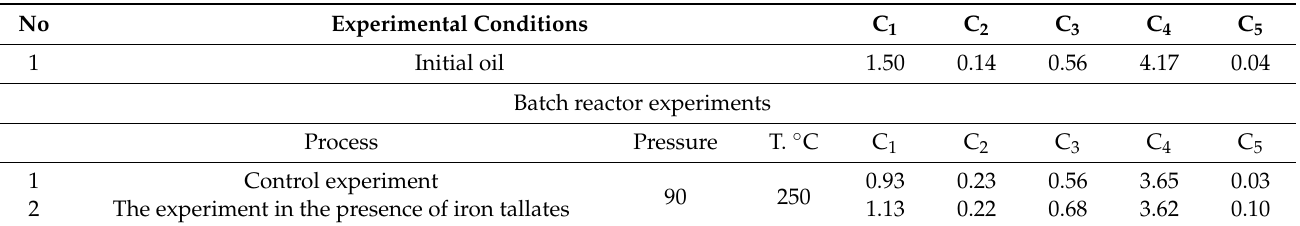
Table 6. Results of IR spectral analysis of oil